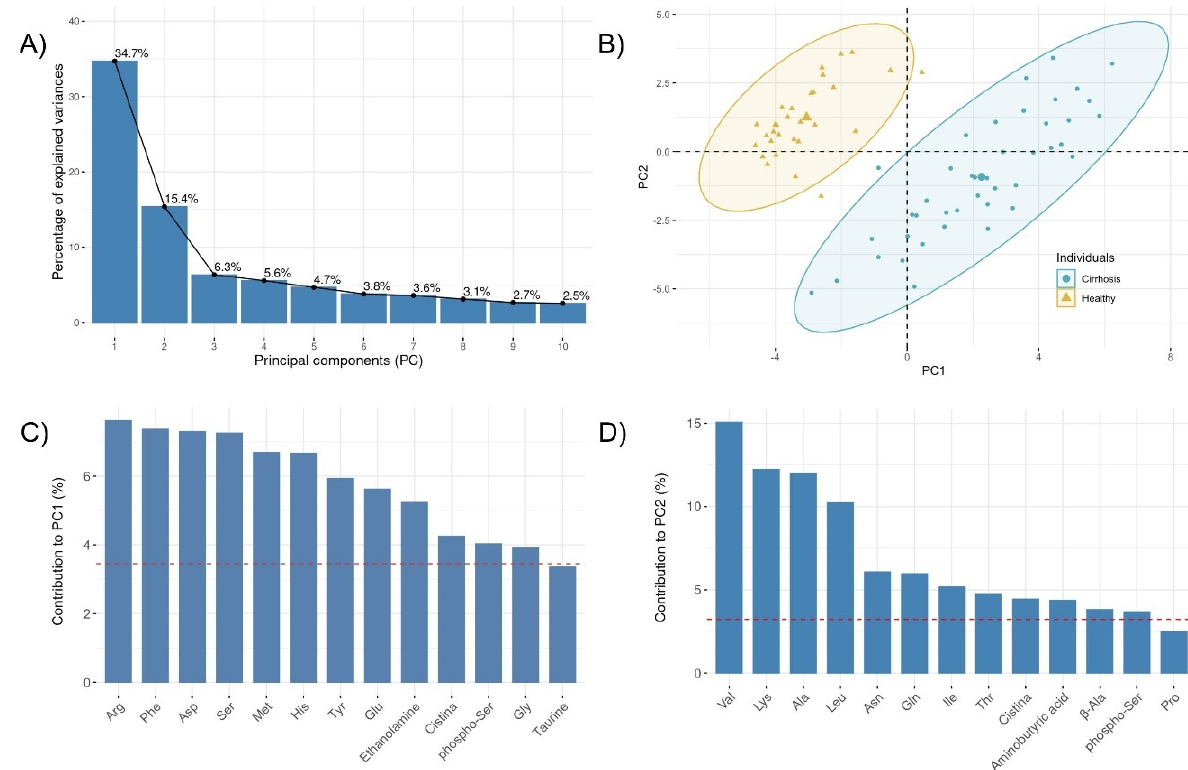
Figure 1. Principal Component Analysis (PCA). Scree plot with the proportion of information retained by each principal component ( A ). Biplot of individuals ( B ). The most contributing variables to the principal component 1 ( C ) and principal component 2 ( D ). The red dashed line indicates the expected average contribution.